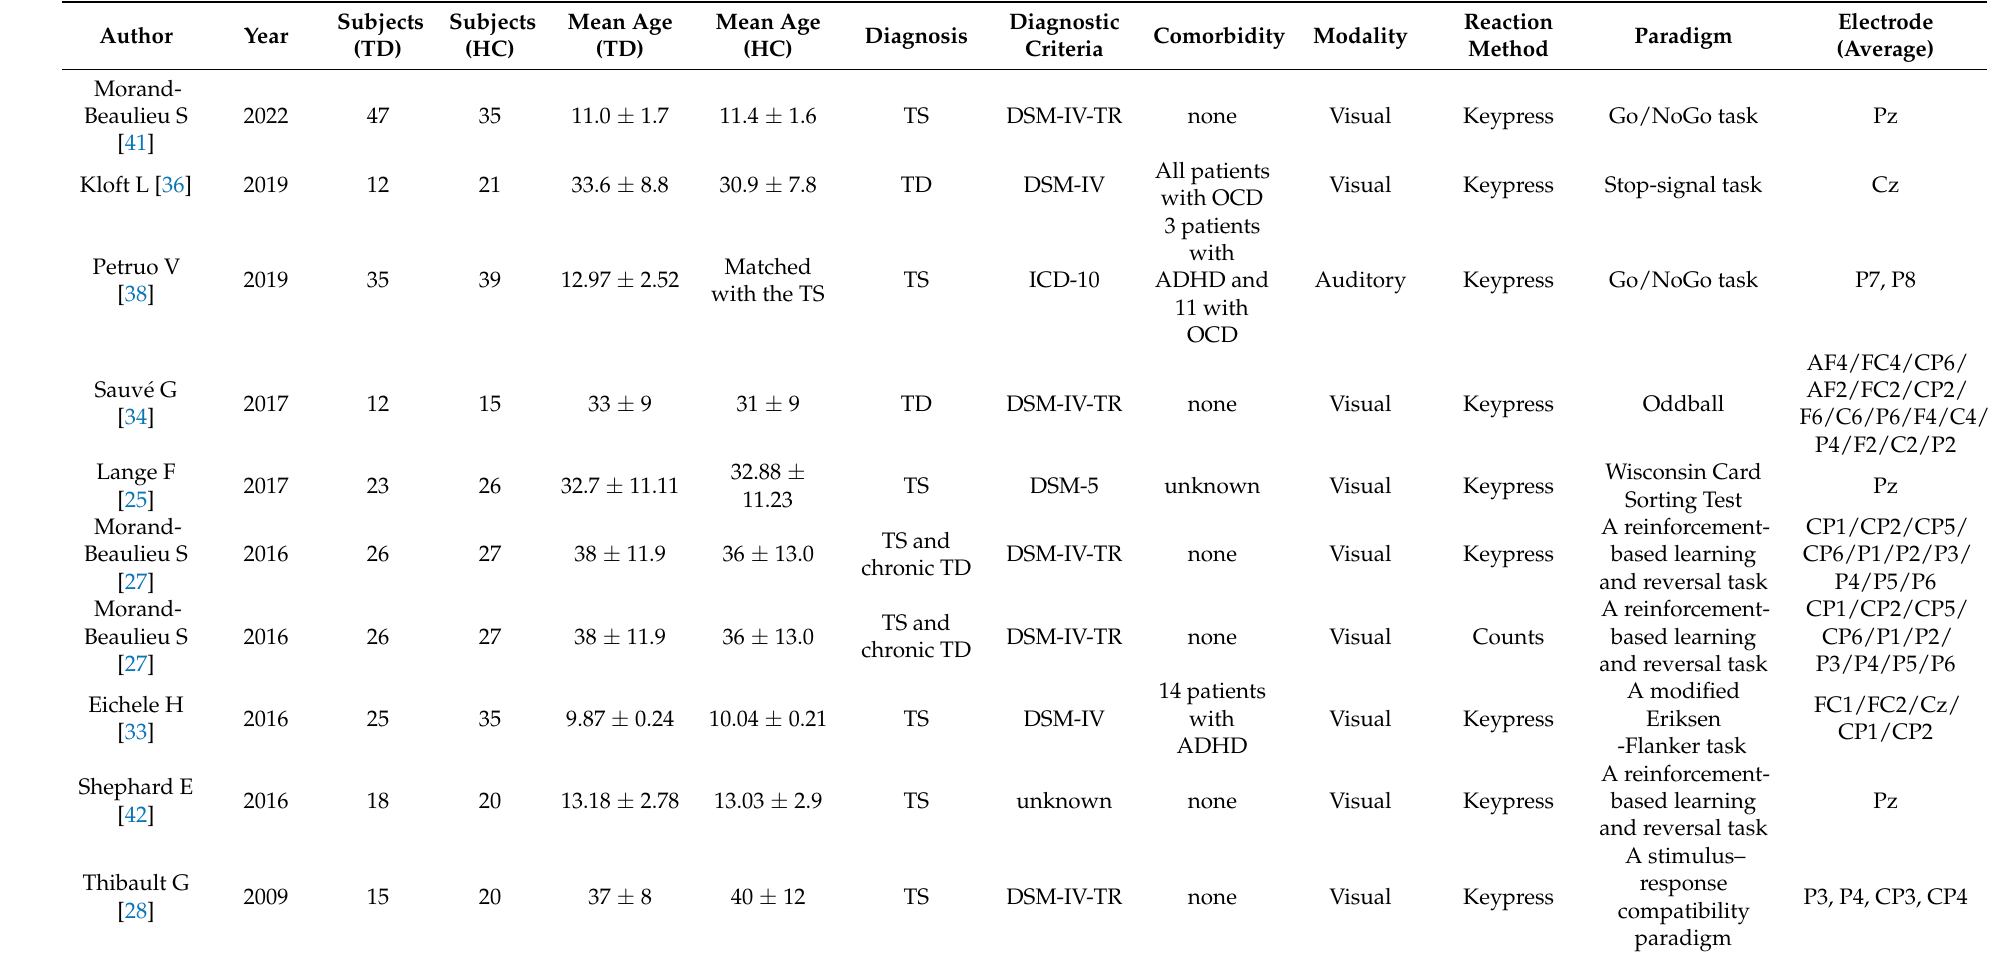
Table 1. Studies on the P3b wave included in this